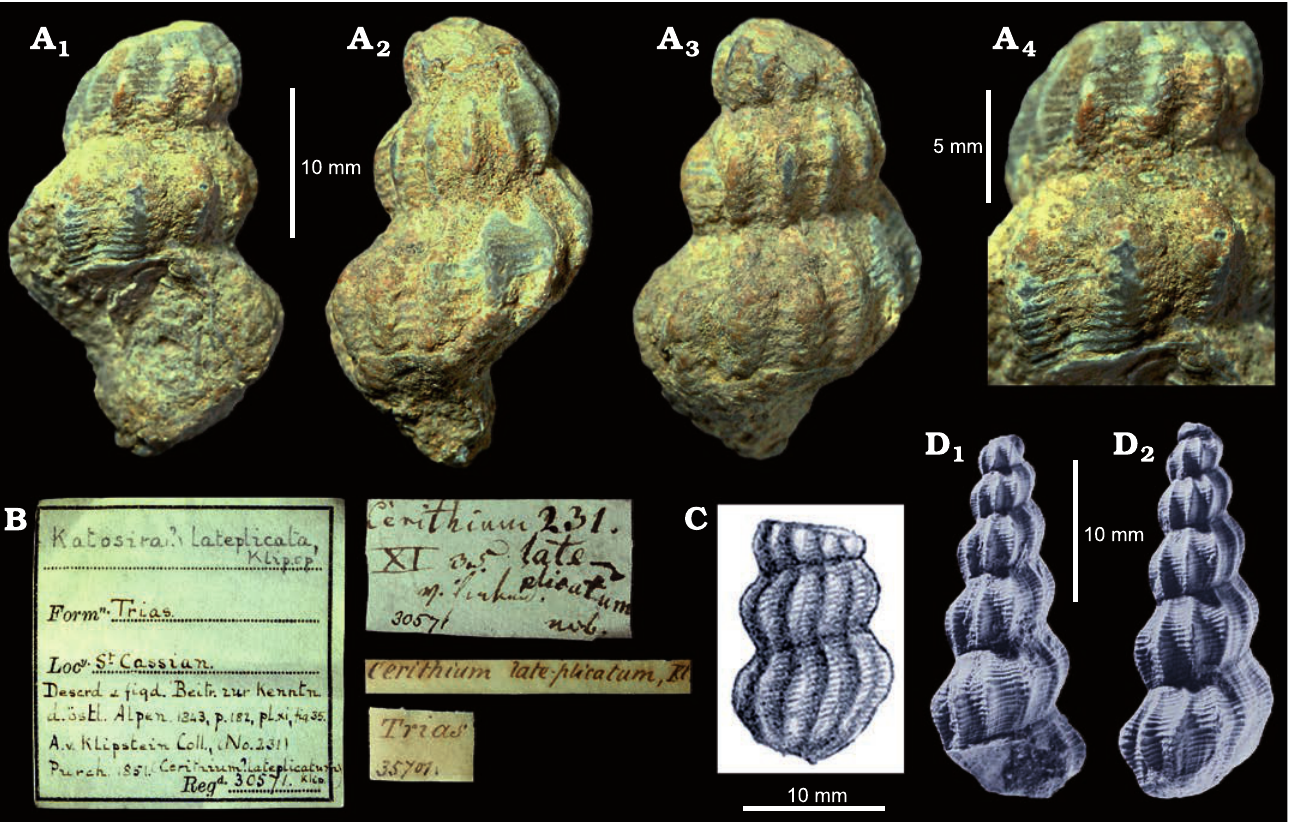
Fig. 4. Zygopleurid? gastropod Ederazyga lateplicata (Klipstein, 1843); lower Carnian, eastern Dolomites (Southern Alps, northern Italy). A . Holotype NHMUK PI OR 35701, incomplete shell, in apertural (A 1 ), dorsal (A 2 ), and subdorsal (A 3 ) views, detail of the ornament (A 4 ). B . Original labels of the holo type (the label at the top shows an incorrect inventory number). C . Illustration of a specimen classified by Kittl (1894: pl. 4: 28) as Katosira ? latep- licata . D . Original illustration of the specimen MRZ3711, ascribed by Zardini (1978: pl. 28: 8a, b) to Katosira seelandica var. alta , incomplete shell, in apertural (D 1 ) and dorsal (D 2 ) views, reproduced with permission Tipografia Ghedina